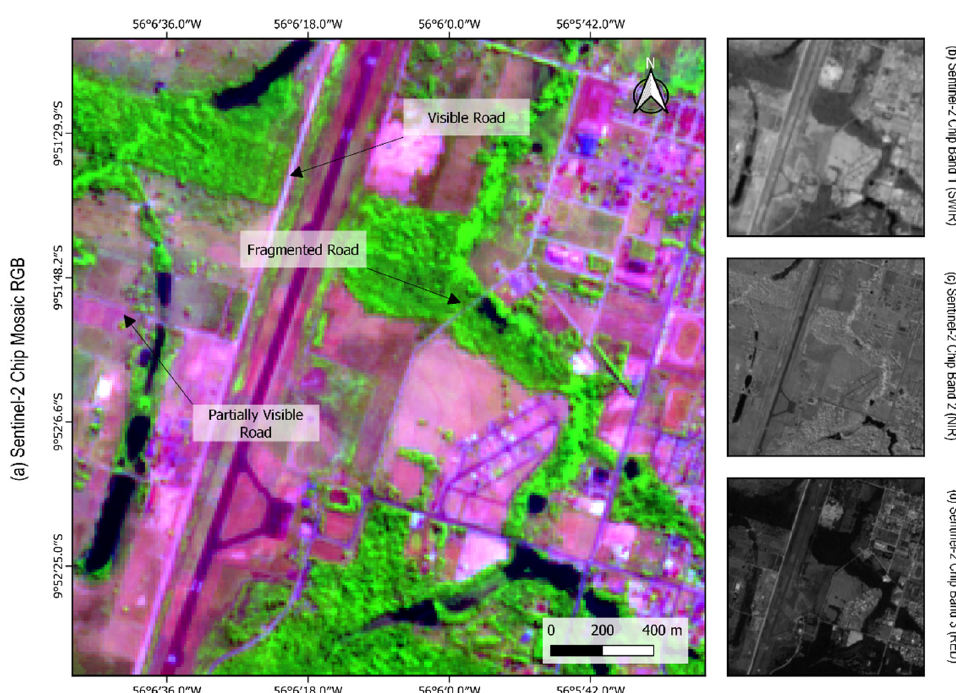
Figure 3. Example of Sentinel-2 RGB (SWIR, NIR, and Red) median mosaicking used to train the U-Net model to detect roads in the Amazon biome. The color contrast stretched image was used to build the training dataset through visual interpretation and hand digitizing three types of roads: visible, fragmented, and partially visible, based on Ref. [8].